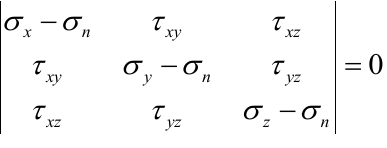
For any oblique plane having a unit normal n = { n x , n y , n z } passing through a point P , the stresses at point P can resolved into a component normal to the plane ( σ n ) and a shear component parallel to the plane ( S n ), as shown in Figure 4b. For a stress to be principal, S n = 0 which implies